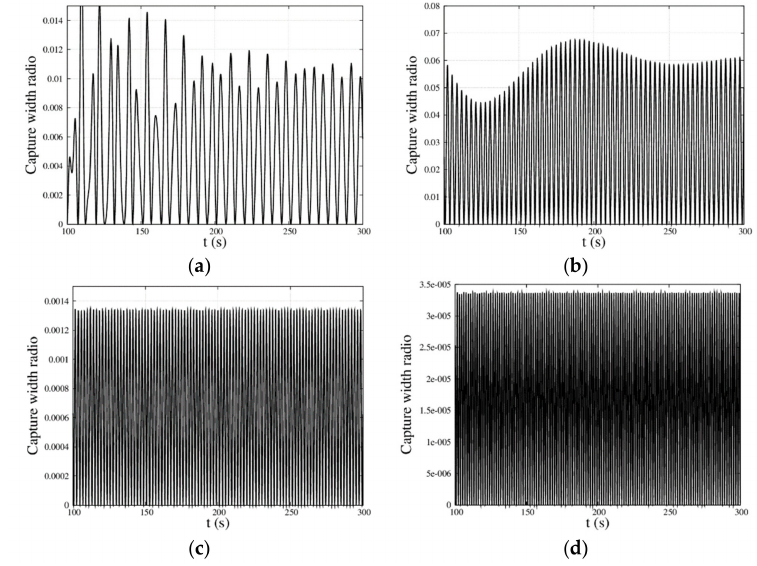
Figure 13. Instantaneous capture width ratio with time for the MP–WEB with di ff erent frequency; ω = 0.5, 1.0, 1.5, and 2.0 ( rad/s ) . ( a ) ω = 0.5 ( rad/s ) ; ( b ) ω = 1.0 ( rad/s ) ; ( c ) ω = 1.5 ( rad/s ) ; and ( d ) ω = 2.0 ( rad/s )